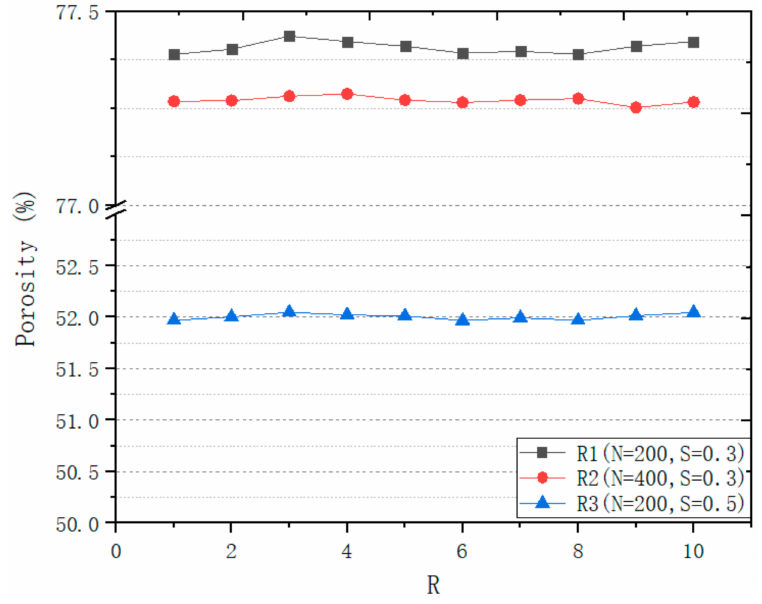
Figure 14. Relationship between R and